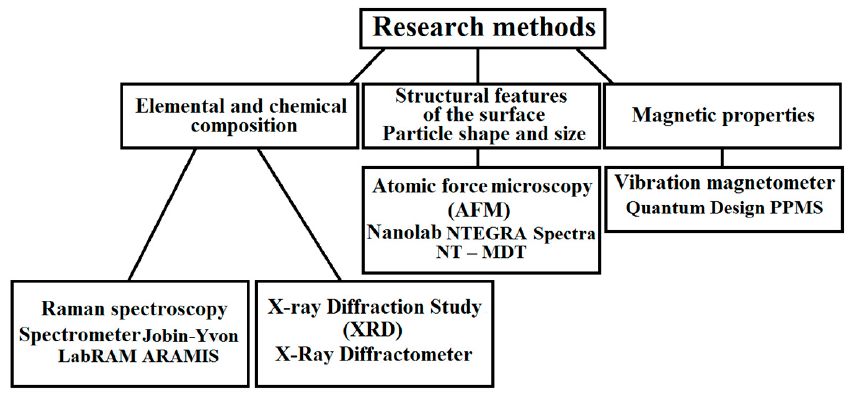
Figure 2. Methods used to analyze the samples and equipment used in this work.